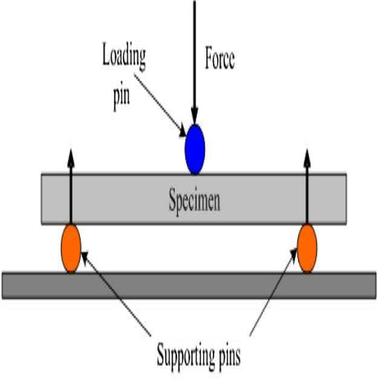
Three point flexure test.